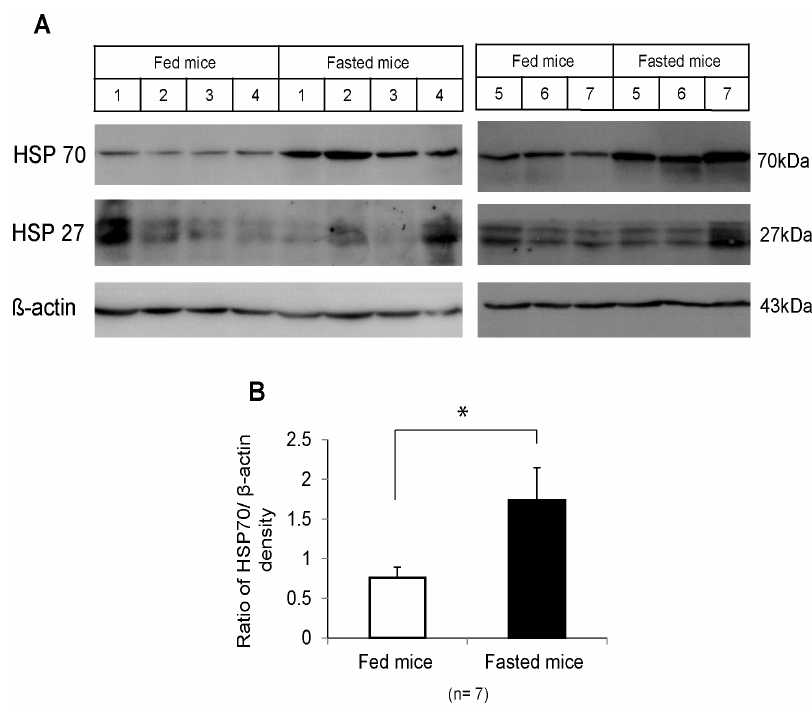
Figure 6. Western blot analysis of heat shock protein expression in fasted mouse livers. (A) Heat shock protein (HSP)70, HSP27, and b - actin expression in the livers from fed mice (control) and 3-day-fasted mice (7 mice in each group) was determined by western blot. (B) The bar graph shows the average HSP70/ b -actin densities plus standard error of the mean; densities were analyzed using ImageJ software. Statistical analyses were performed using the independent samples T test. * p ,